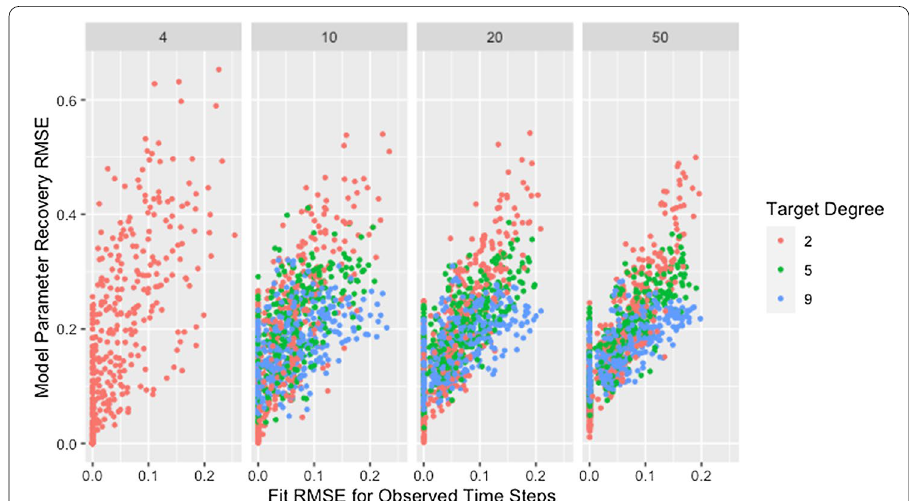
Fig. 2 RMSE for model parameter recovery by fit RMSE, degree, and size. RMSE for known and predicted weights by RMSE for observed and predicted opinions on observed time steps, target degree, and network size across